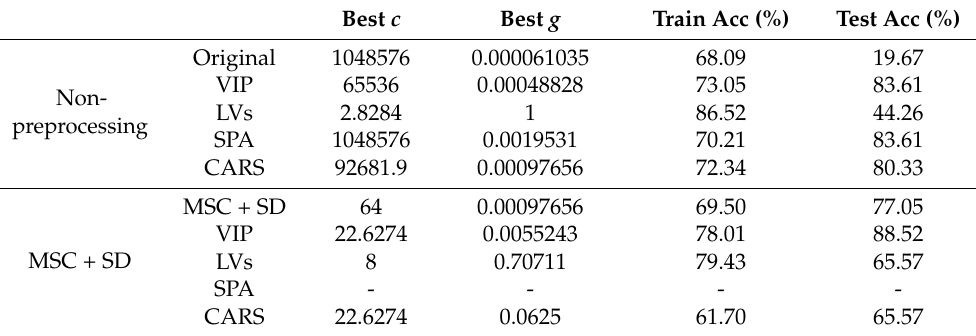
Table 3. Parameters of SVM Model Based on